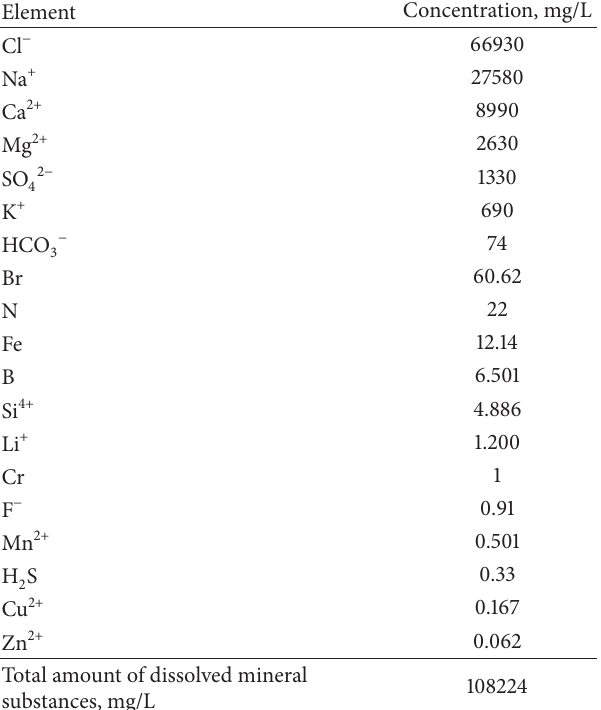
Table 1: The mineral composition of geothermal